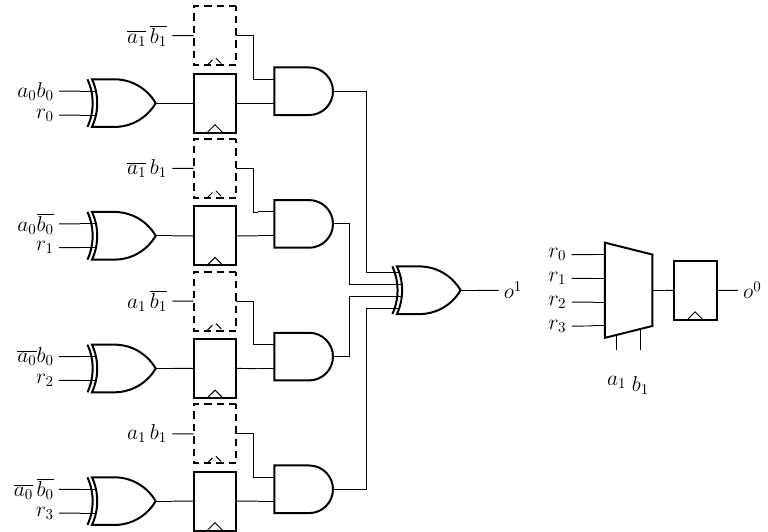
Figure 3: First-order GHPC LL - AND realizing o = ab . Dashed registers are optional but necessary to make a pipelined